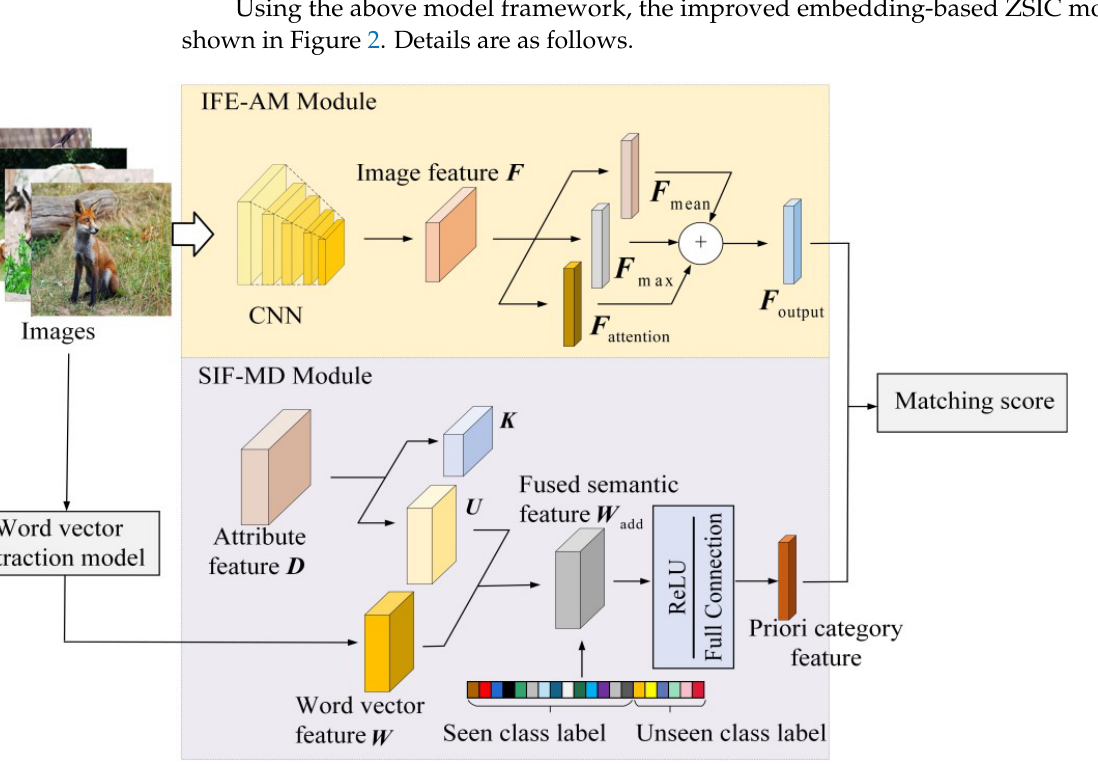
Figure 2. Improved ZSIC model.